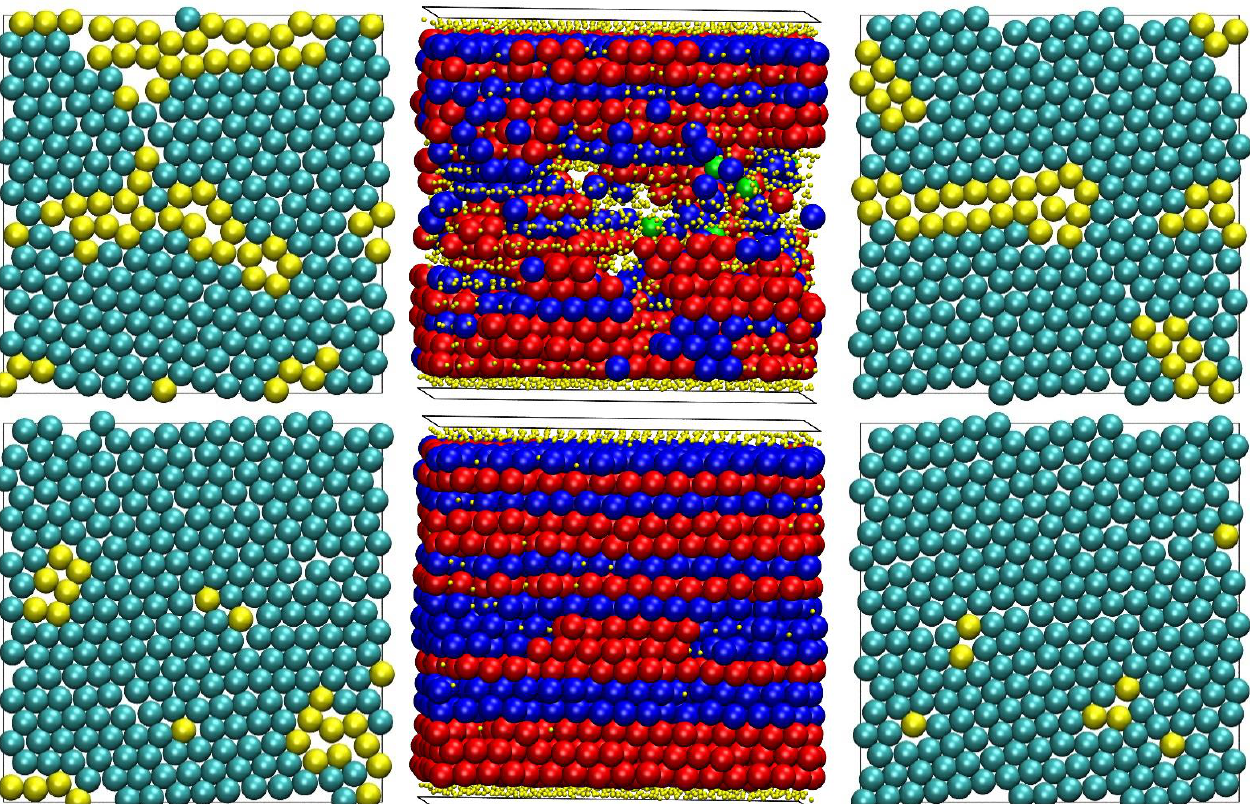
Figure 13. Snapshots of the system configurations for the N = 100 at ϕ = 0.60 at various instances along the MC simulation. ( Left ), ( middle ), and ( right ) panels correspond to the bottom layer, bulk volume, and top layer of the confined simulation cell. From ( top ) to ( bottom ): 2 × 10 7 , 1 × 10 11 , 2 × 10 11 , 3 × 10 11 , 4 × 10 11 , and 2 × 10 12 MC steps. The atoms are colored-coded according to the crystal similarity, as identified by the CCE-norm analysis. The figure panels are also available as 3-D, interactive images.